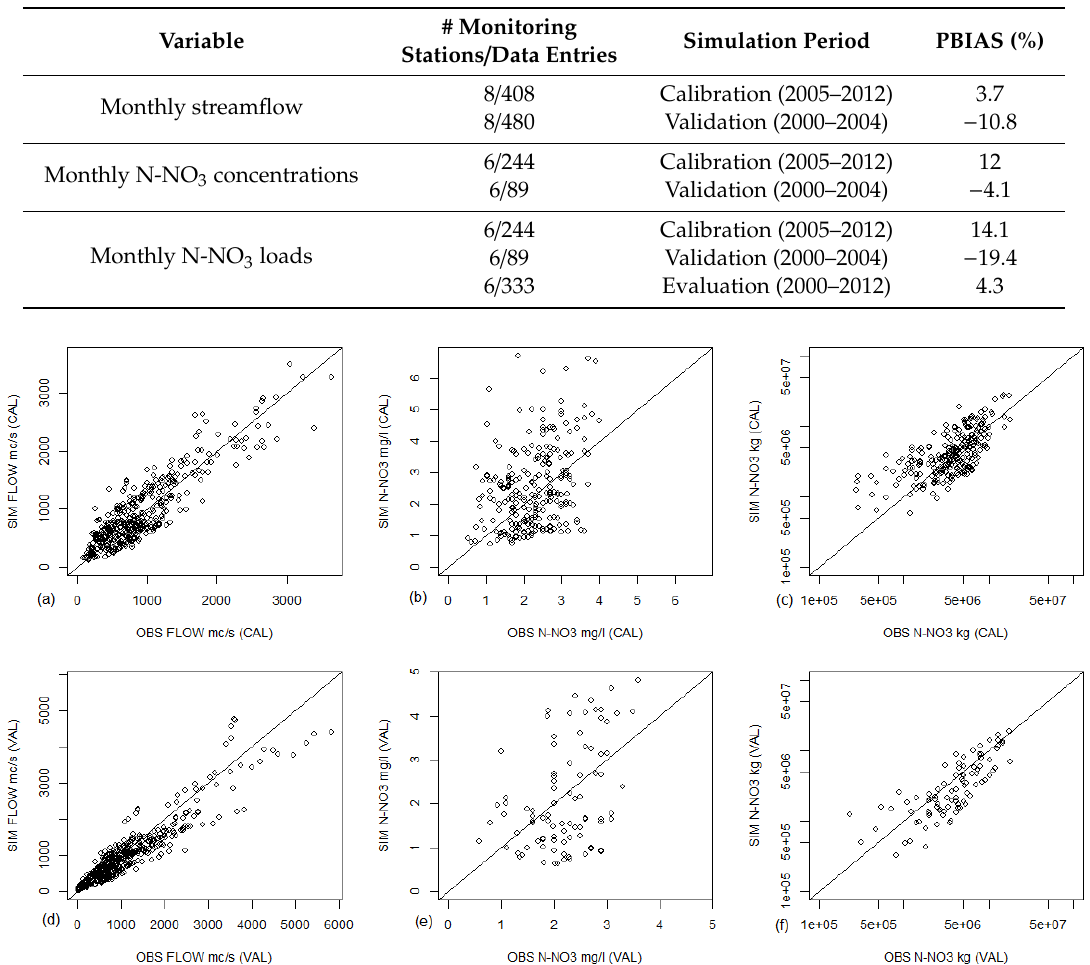
Figure 3. Comparison of simulated (SIM) and observed (OBS) monthly streamflow (m 3 / s), N-NO 3 concentrations (mg / L) and loads (kg / month) in the calibration (CAL, upper three graphs) and validation (VAL, lower three graphs) periods.